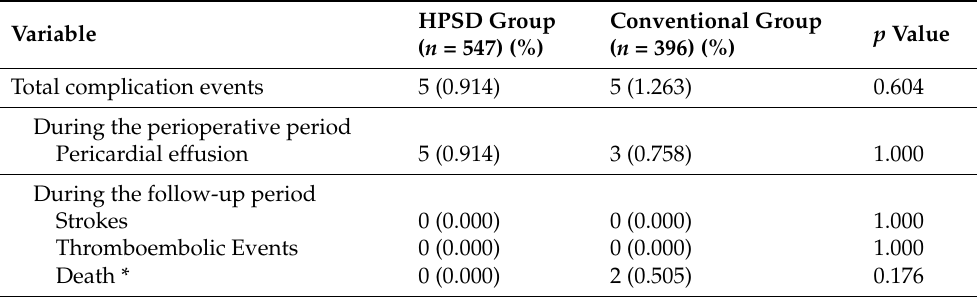
Table 8. Complications in the two The dots indicate the site of the trigger. The red dots represent the HPSD group, and